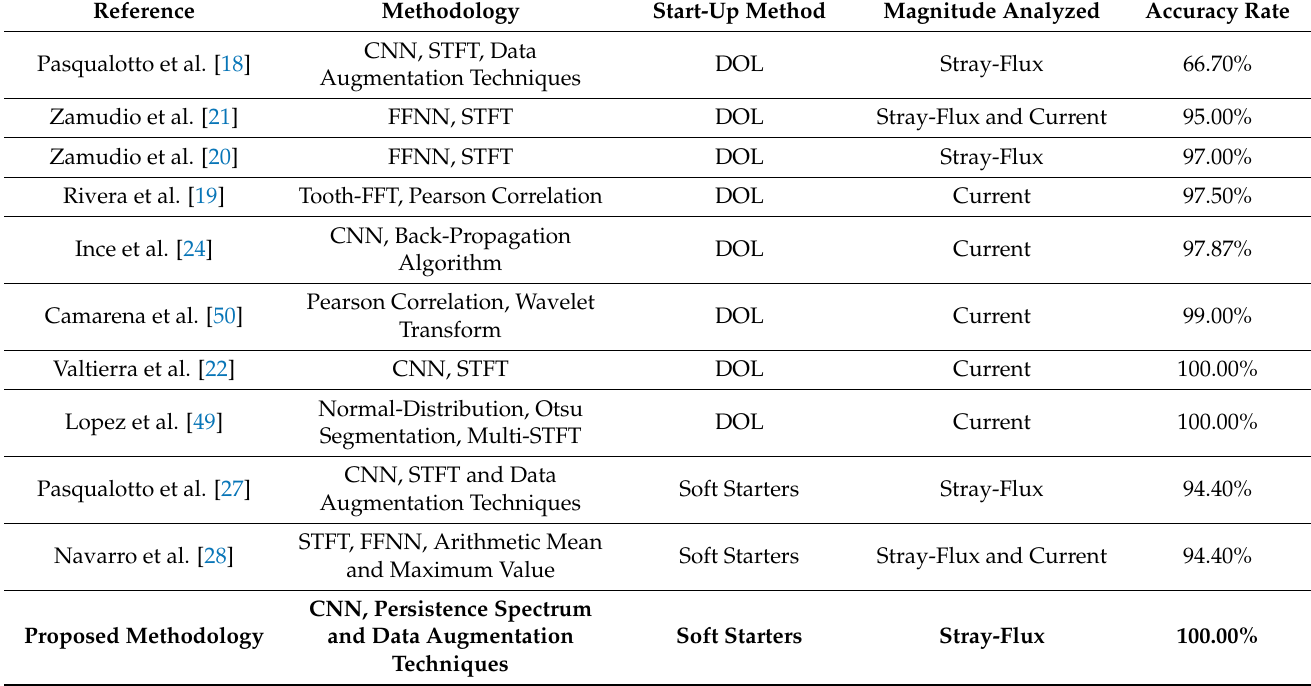
Table 9. Proposed methodology compared with other methodologies used for automatic detection of rotor bar